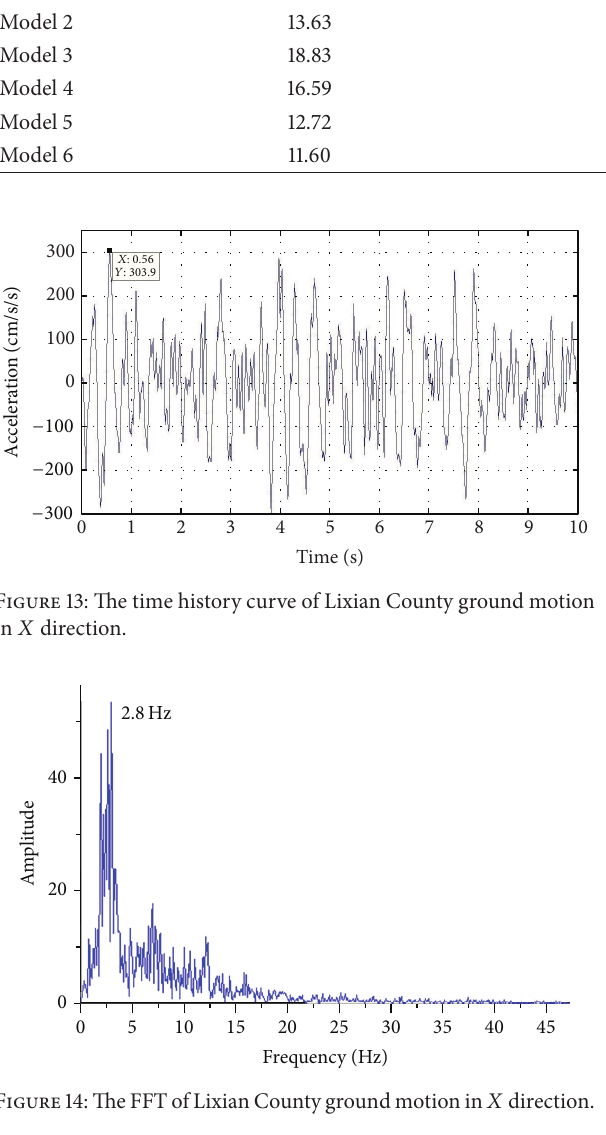
Figure 16: The FFT of Lixian County ground motion in 𝑌